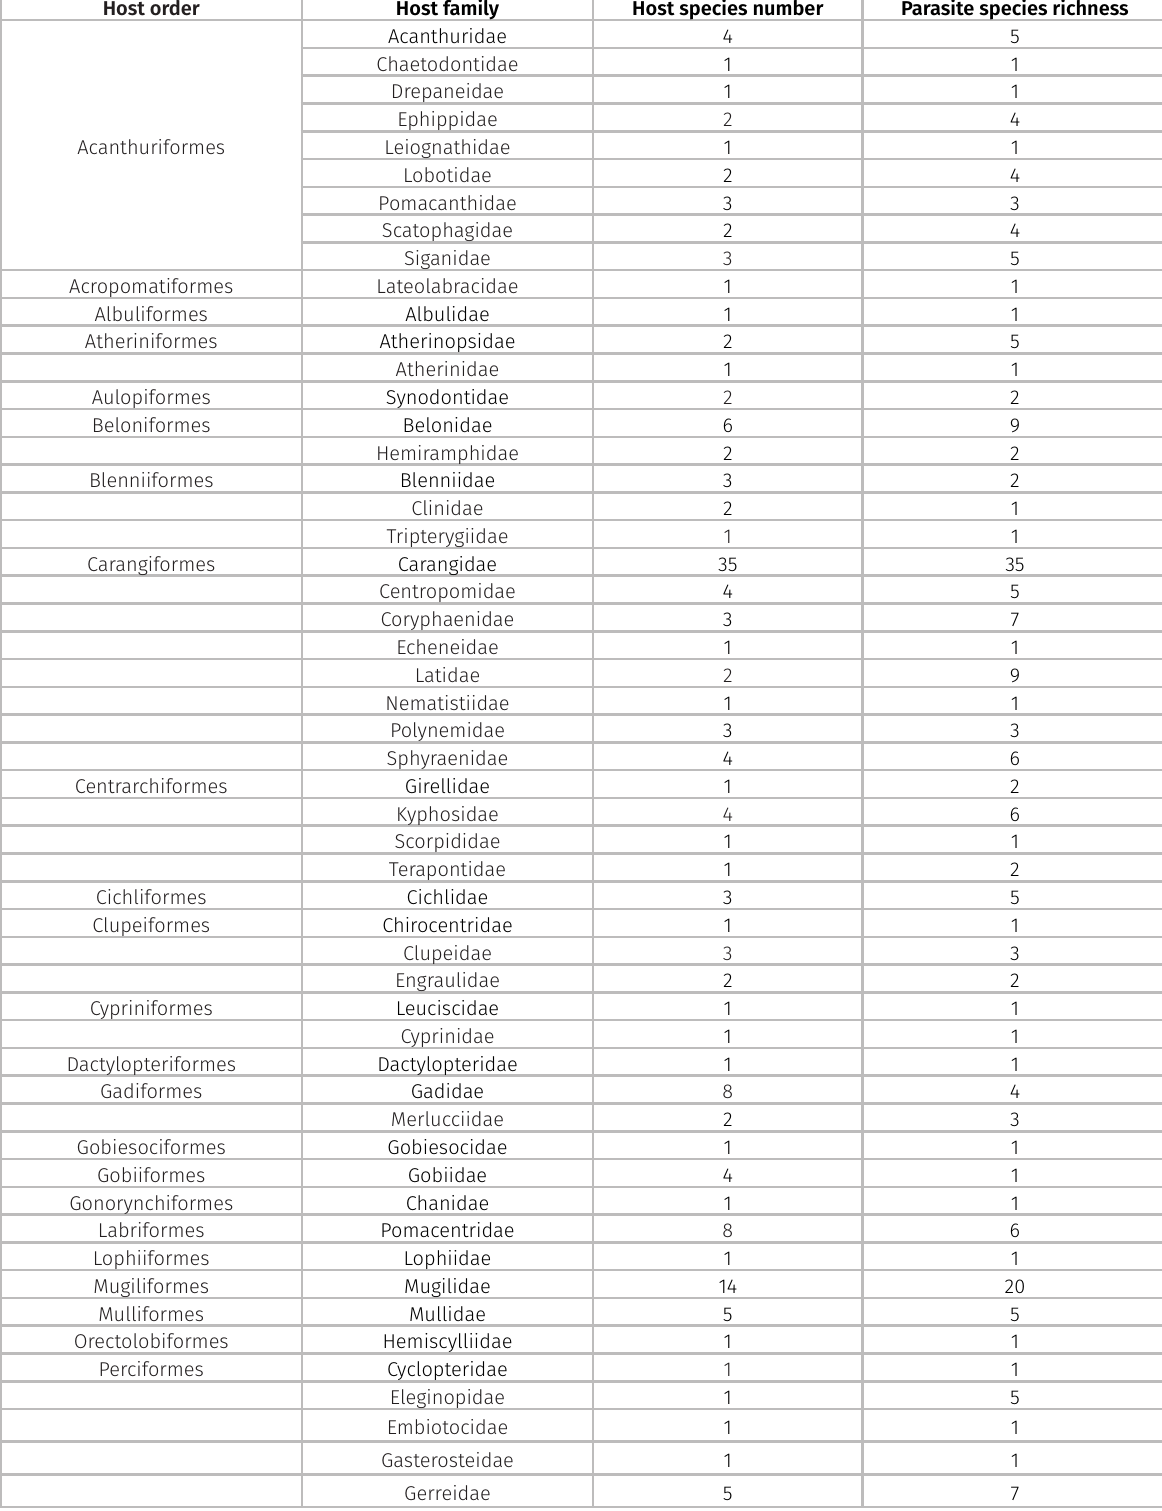
Table I. Richness of Caligus species by taxonomic groups in 368 teleost species. Host